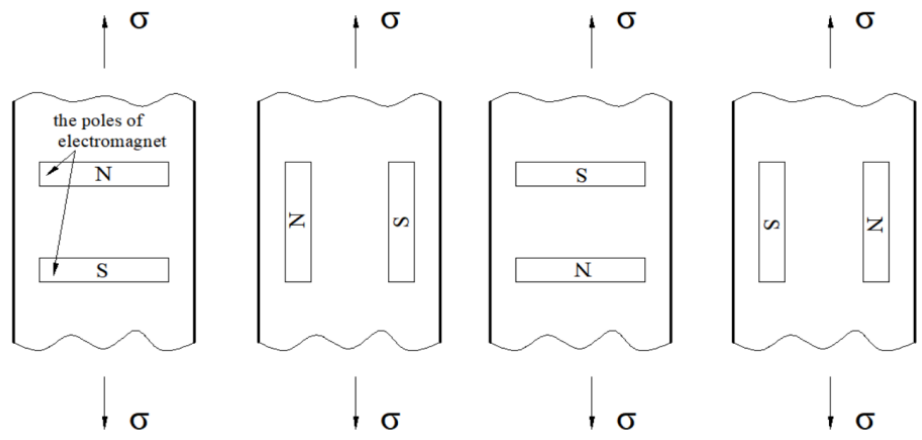
Figure 2. Position of the U- shaped electromagnet on a test specimen, at θ = 0°, 90°, 180°, and 270°. During the tensile testing, the normal components of the magnetic field B Z on the surface of specimens were measured on-line using a sensor plate arranged on the other side of the specimens, the key parts of the plate are 9 magnetic probes based on TMR sensors, as shown in Figure 3. Please note that the probe output is negative for the N pole and positive for the S pole. The sensitivity of the magnetic probe was 2.2 mv/V/Gs.